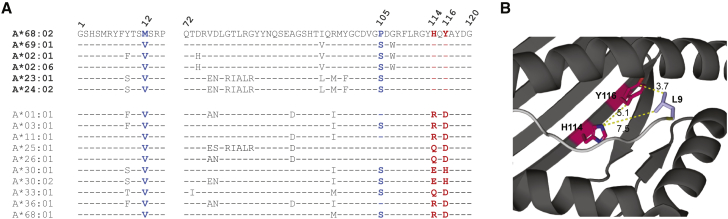
H114/Y116 Residue Combination Is Conserved Exclusively across All HLA I Members of the A2 and A24 Superfamilies(A) Amino acid sequence alignment across members of all HLA-A superfamilies, spanning residues 1–12 and 72–120; residues 114 and 116 (red) as well as residues 12 and 105 (blue) were highlighted.(B) PyMOL image of the structure of HLA-A∗68:02 folded with peptide SVYDFFVWL (PDB ID 4HX1); residues H114 and Y116 are highlighted in red, the L9 residue of the peptide in light blue, and the peptide backbone in gray. Dotted yellow lines indicate the shortest distances between the connected amino acid residues, measured in Å.